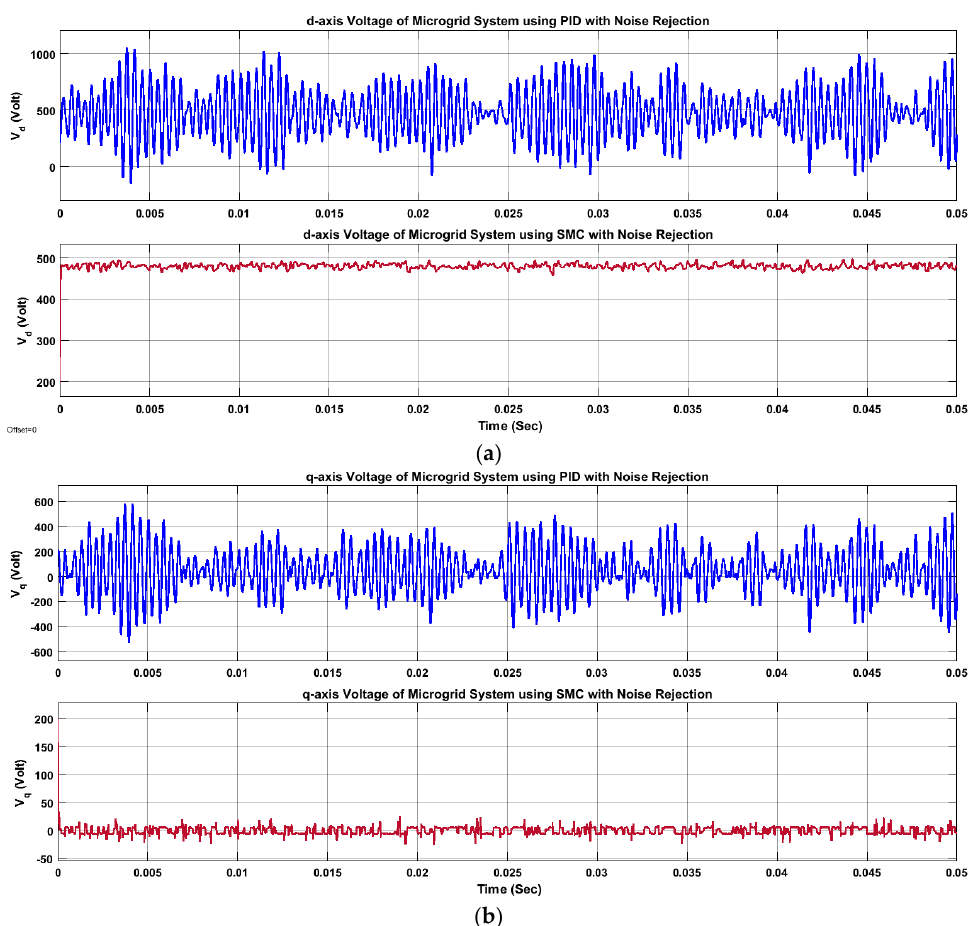
Figure 13. Performance comparison between PID (blue colored) and SMC (red colored) in the case of ( a ) real axis output voltage ( V d ) and ( b ) reactive axis output voltage ( V q ) considering noise rejection.